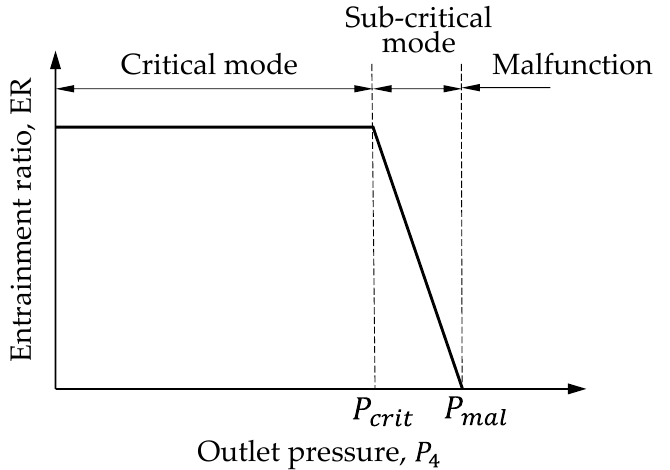
Figure 2. Various ejector operation modes at a fixed primary and secondary inlet pressures. Entrainment ratio (the y-axis) is the ratio of secondary to primary mass flow rates.